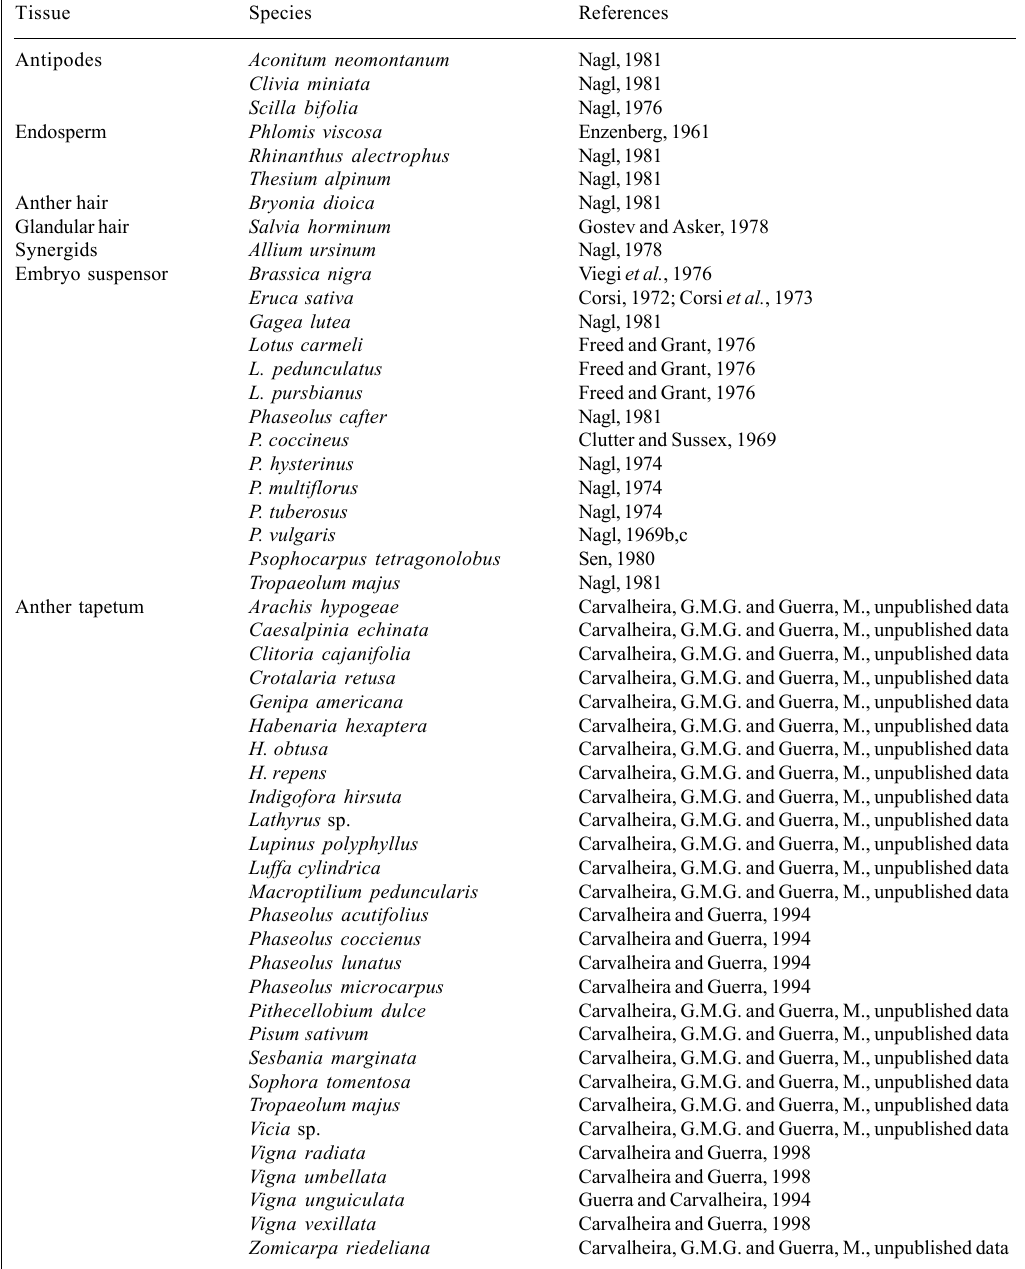
Table I - Occurrence of polytene chromosomes in